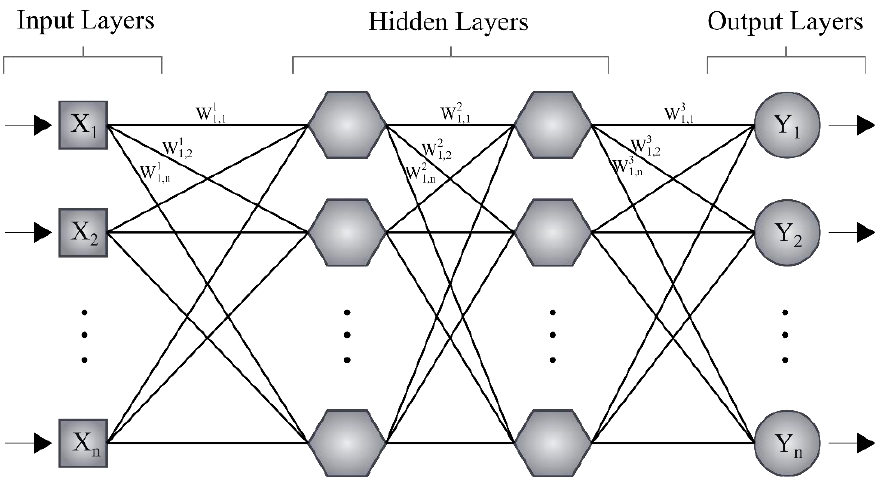
Figure 8. Example of an multilayer perceptron (MLP) neural network structure.